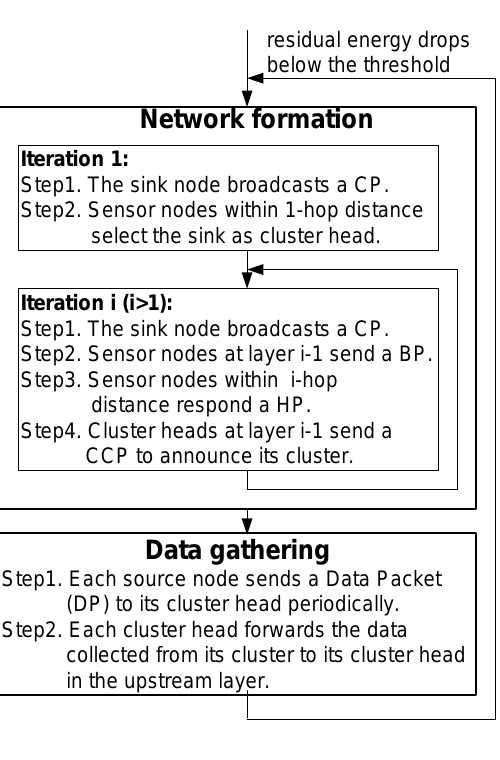
Figure 2. Network operation